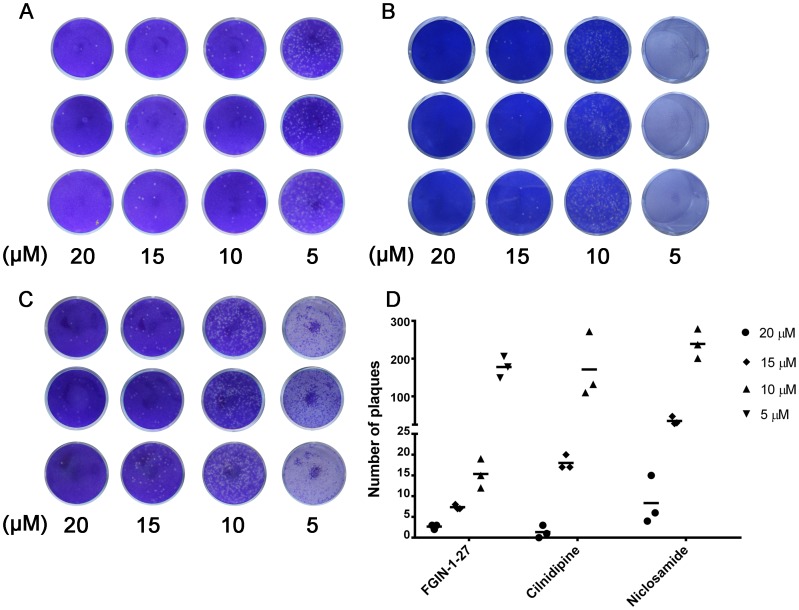
Identification of antiviral effects of the compounds by plaque reduction assay.JEV was propagated in BHK-21 cells in the presence of different concentrations of compounds for 48 h, and the virus titer was tested by plaque assay. A–C show plaque reduction assay of compounds FGIN-1-27, cilnidipine and niclosamide, respectively. The plaque numbers at different concentrations were counted and plotted in panel D.